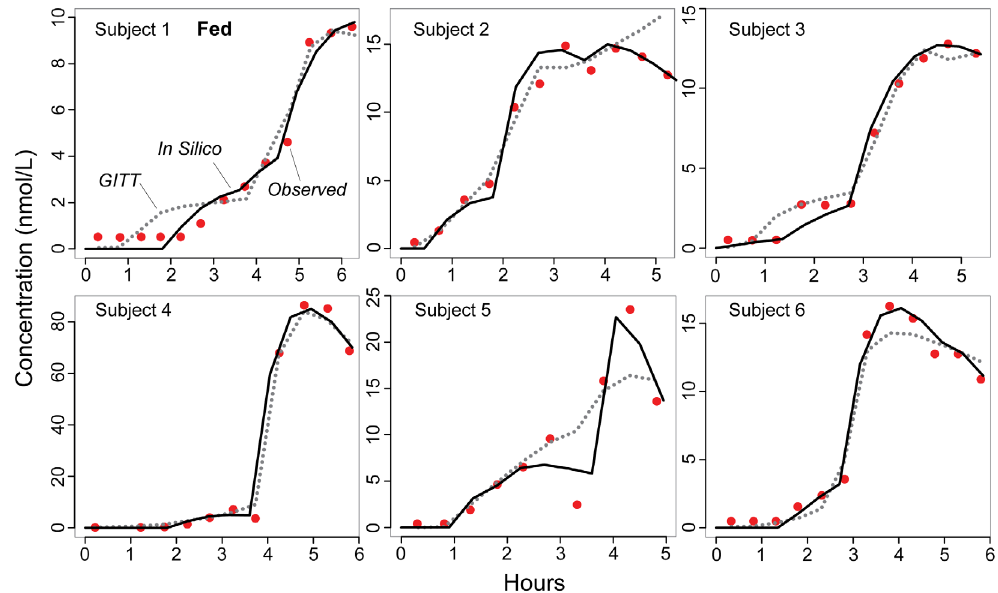
Figure 4. Felodipine plasma concentrations following food intake. We used the same protocol described in Fig. 3 and in Methods to simulate drug disposition under the fed condition. Red circles: observed concentrations [8]; black lines: analog outcomes; dotted curves: the GITT